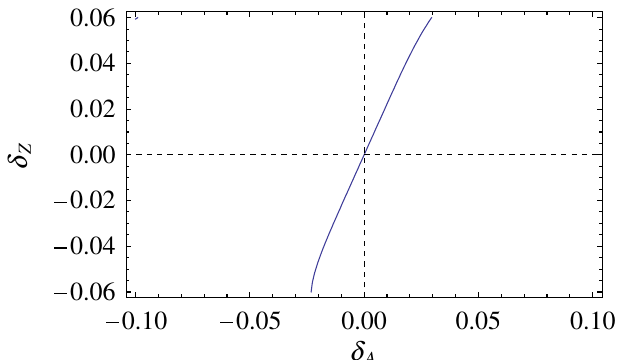
FIG. 14. (Color) Separation cut including nonlinearities up to third order. The origin corresponds to a 400 MeV = u 132 Sn beam and wedge thickness corresponding to 45% of the